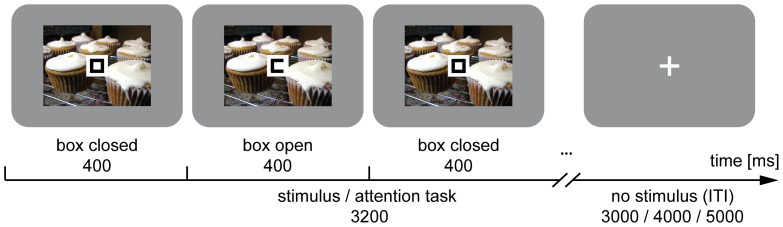
Paradigm.On each trial, one of 24 IAPS images was presented in the background for 3.2 s while participants engaged in an attention-demanding foreground task. They continuously monitored the random opening of a box (alternating between 400 ms closed, 400 ms opened) and responded to the side of each opening with a left or right button press using the left and right index finger. This task phase was followed by a jittered delay of 3 s (25%), 4 s (50%) or 5 s (25%) in which only a white fixation cross was shown. Each image was shown 3 times per block (total of 72 trials per block), and participants finished 6 blocks (total of 432 trials) with an individually randomised order of images for each participant and each block.